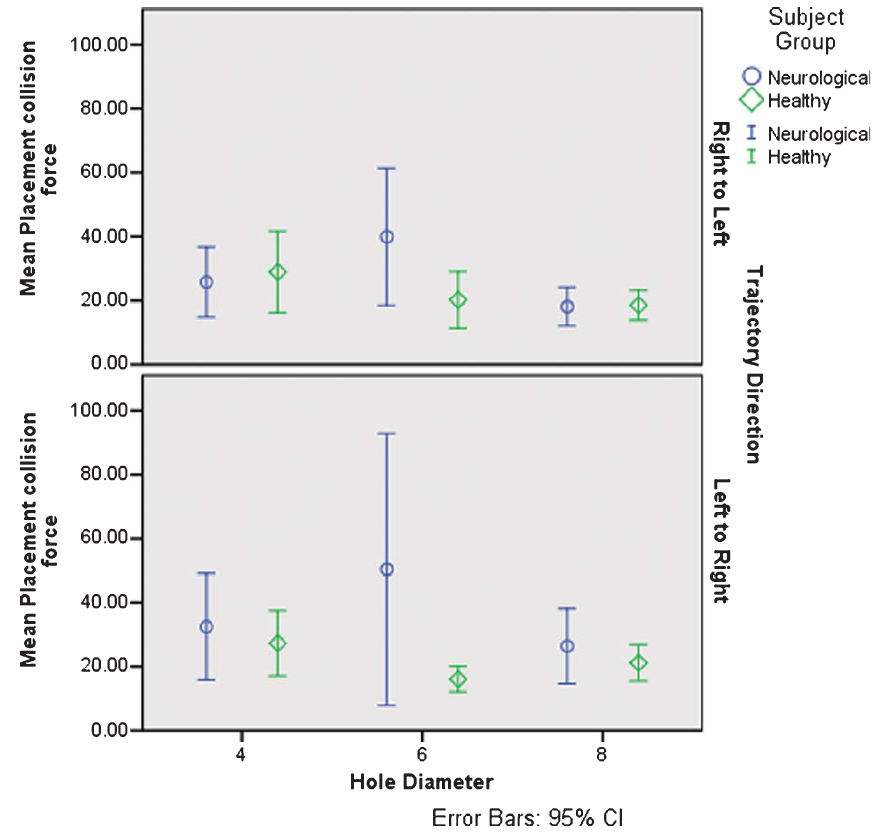
Fig. 7. Comparing collision forces for R2L and L2R half cycles and subject